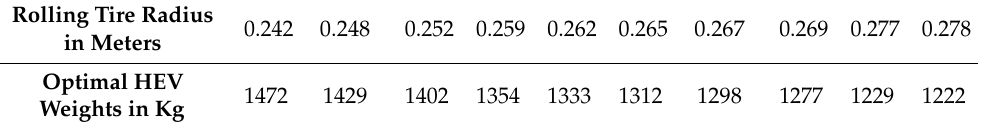
Table 4. Optimal HEV weights vs. tire radiuses. Table 5. Compared fuel consumption of optimal vs. normal